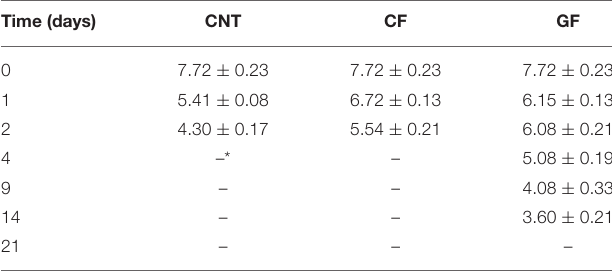
TABLE 3 | Viable count of B. infantis (log cfu/ml) in saline solution (9 g/l NaCl) supplemented with either Gluten Friendly (GF) or Control Flour (CF) (2.5 g/l).